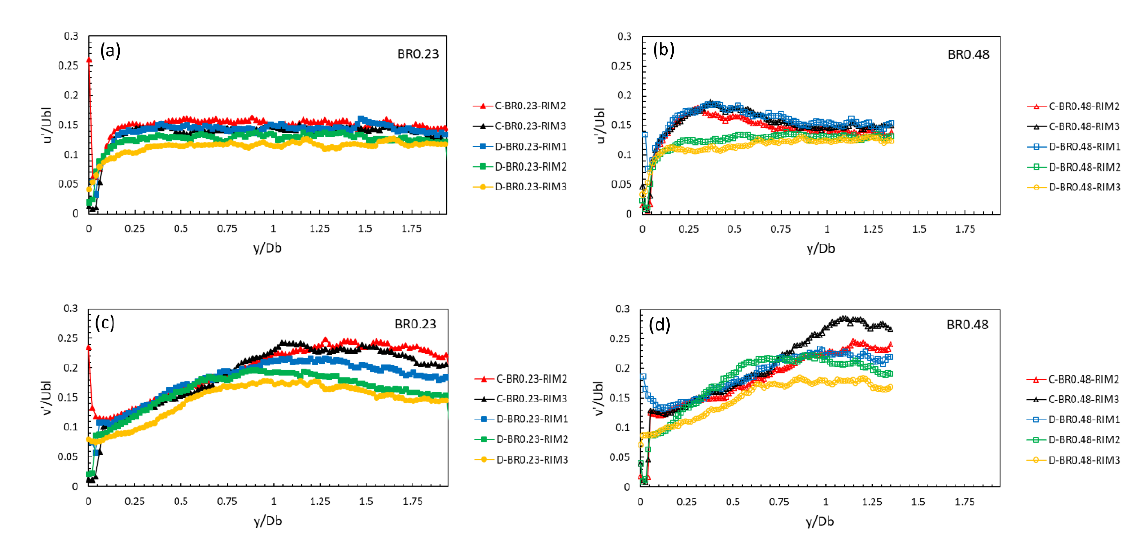
Figure 7. Centerline profiles of the axial ( a , b ) and radial ( c , d ), RMS velocity components normalized by Ubl (i) BR0.23 and (ii) BR0.48 baffles.